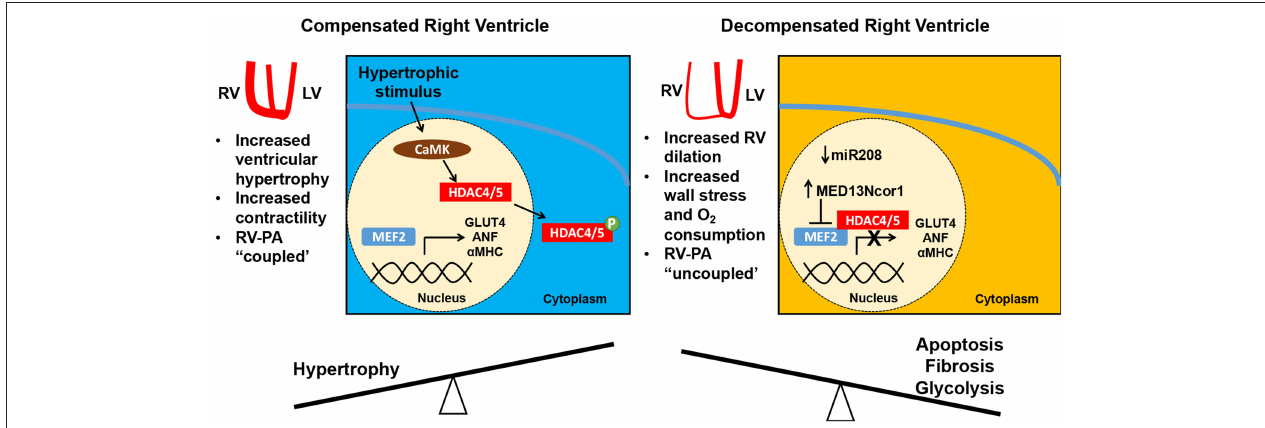
FIGURE 1 | Right ventricular (RV) adaptation in pulmonary hypertension. In response to increasing pulmonary arterial (PA) pressure, the RV hypertrophies and augments its contractility (RV-PA coupling is maintained). This adaptive RV hypertrophic response is mediated in part by MEF2C with expression of MEF2 targets such as GLUT4, ANF, and aMHC. However, with a progressive increase in RV afterload the RV dilates, increasing the free wall stress and myocardial oxygen consumption. Consequently, the RV-PA unit is uncoupled. During this decompensated phase, there is a decrease in MEF2C levels, which is linked to mir208 suppression and